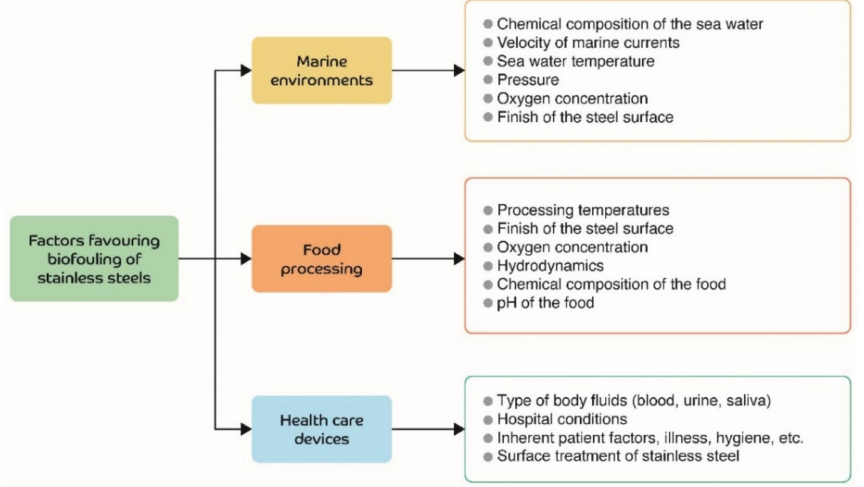
Figure 1. Biofouling factors in stainless steels devices used in the environments